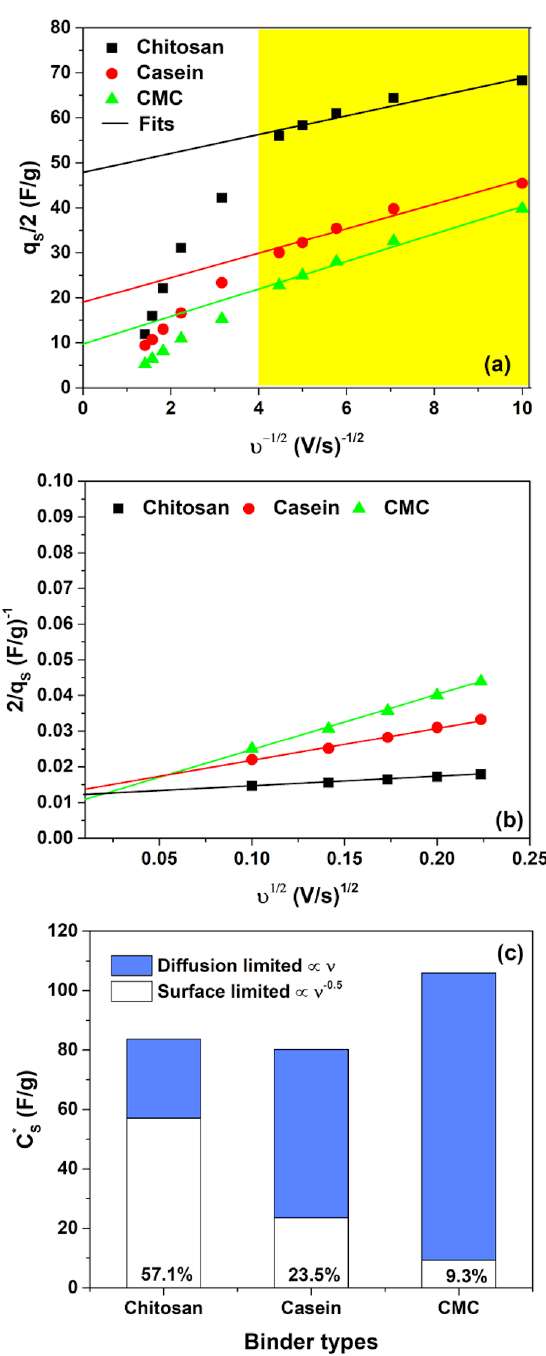
Figure 3. ( a ) Dependence of q s on υ −0 .5 and ( b ) of 1/q s on υ 0 .5 for the binders investigated in hydrogel 2 M NaCl; ( c ) contribution of pseudocapacitance (diffusion-limited) and double-layer capacitance (surface-limited) to the overall capacitance 𝐶 𝑆∗ for all the binders investigated. Here, q s is the total voltammetric charge. The yellow box area indicates the region where the linear fitting procedure is performed.